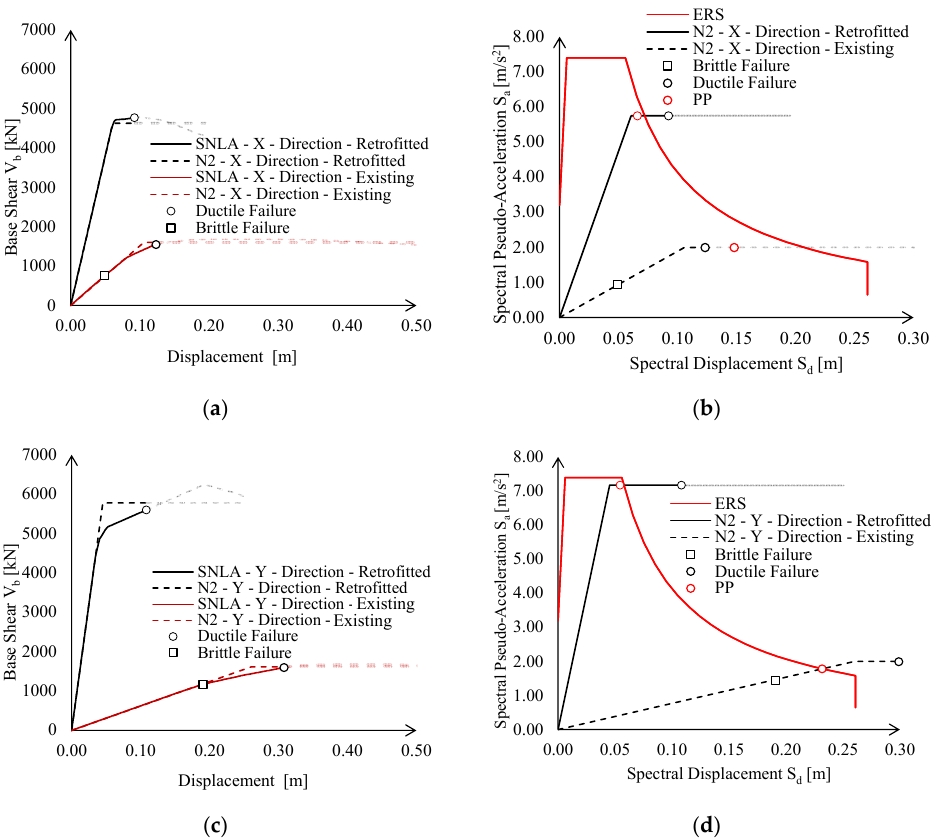
Figure 16. Global performance of existing structure in terms of pushover curves (( a ) and ( c ) in X and Y directions respectively) and ADRS domain checks according to EN1998:3 [31] provisions (( b ) and ( d ) in X and Y directions respectively). Table 3. Seismic and wind checks for the retrofitted structure in terms of displacements.